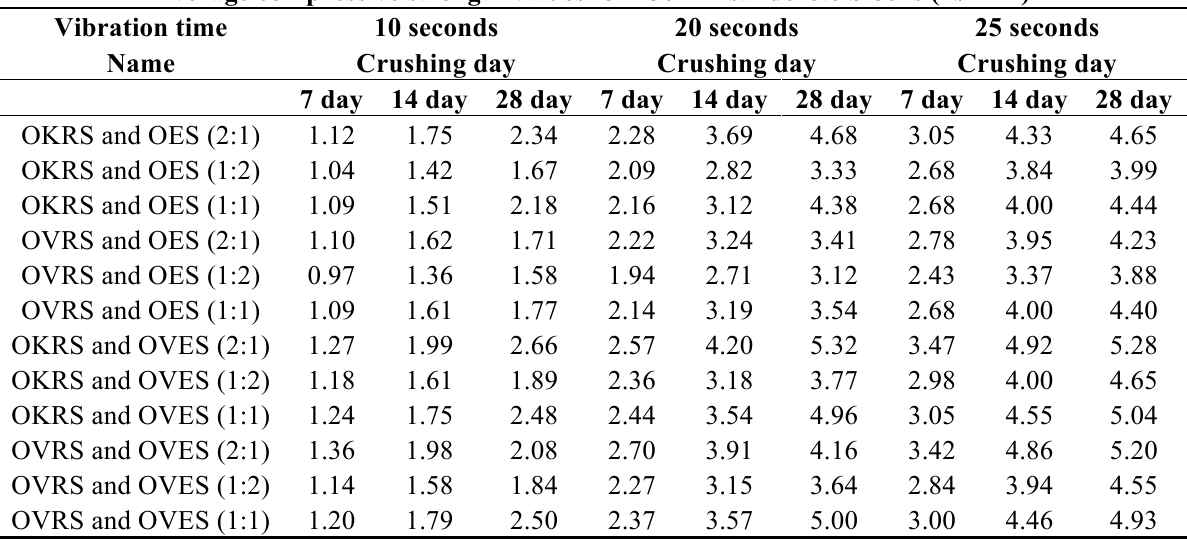
Table 8. Average compressive strength values for 150 mm sandcrete blocks from the various sand combinations and vibration